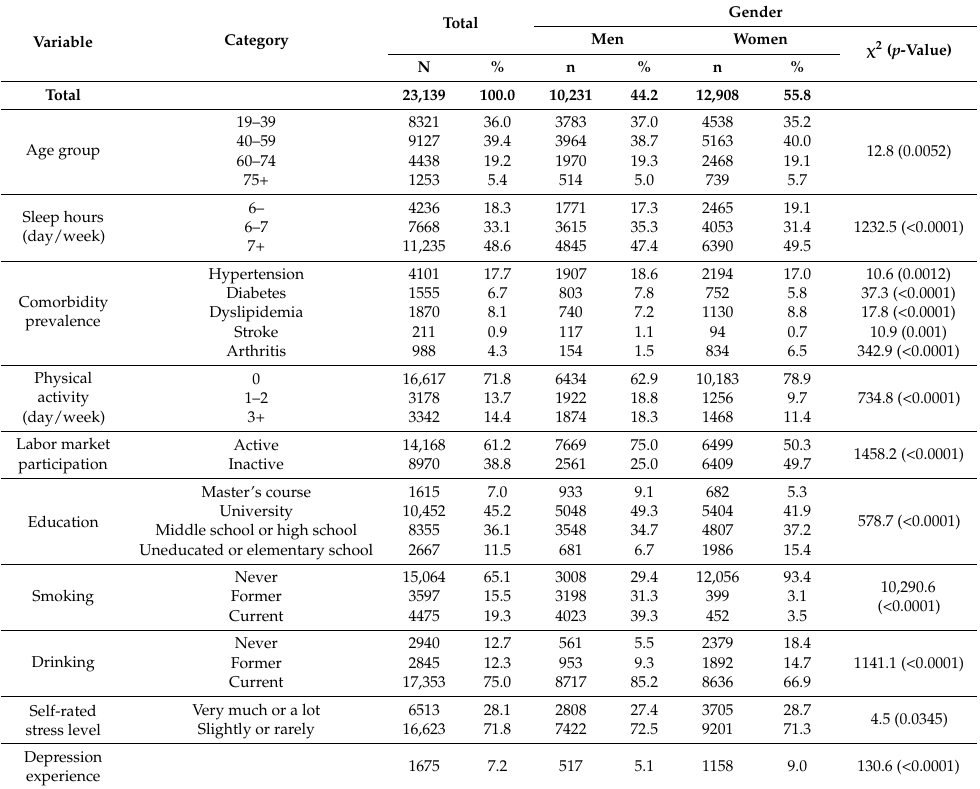
Table 1. Descriptive characteristics of survey populations in the Community Health Survey data in Seoul, Korea,